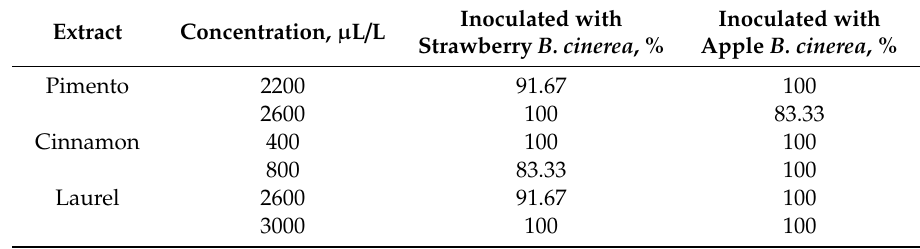
Table 2. Disease incidence on apples treated with extracts at 7 days after